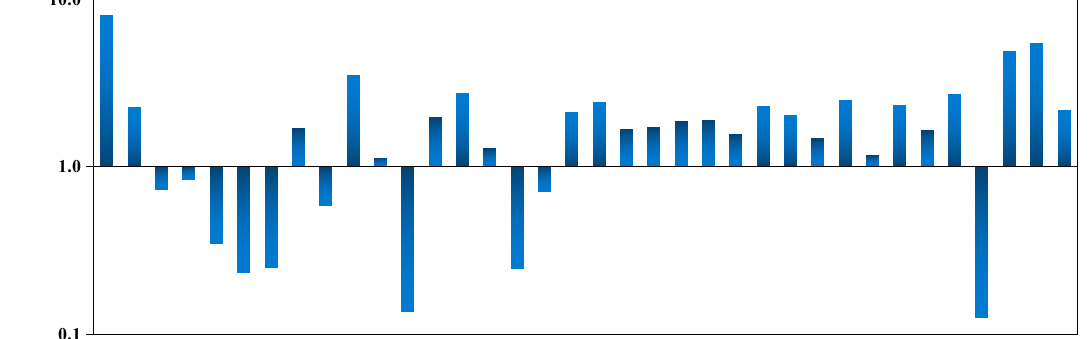
Figure 2. Concentration coefficients of trace elements in the No. 9 coal and related roof samples from the Xinyuan mine.